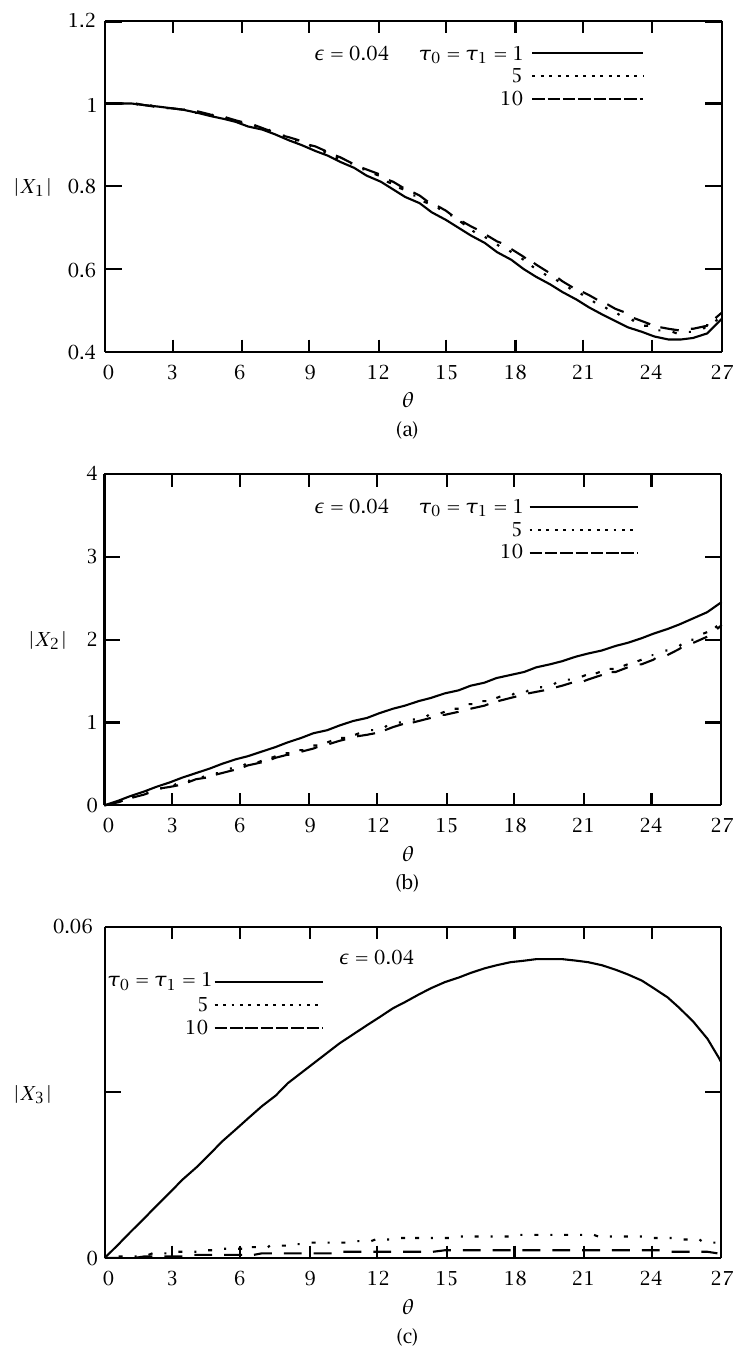
Figure 5 . (The effect of the thermal relaxation times in G-L theory) | X 1 | , | X 2 | , | X 3 | versus the angle of incidence θ